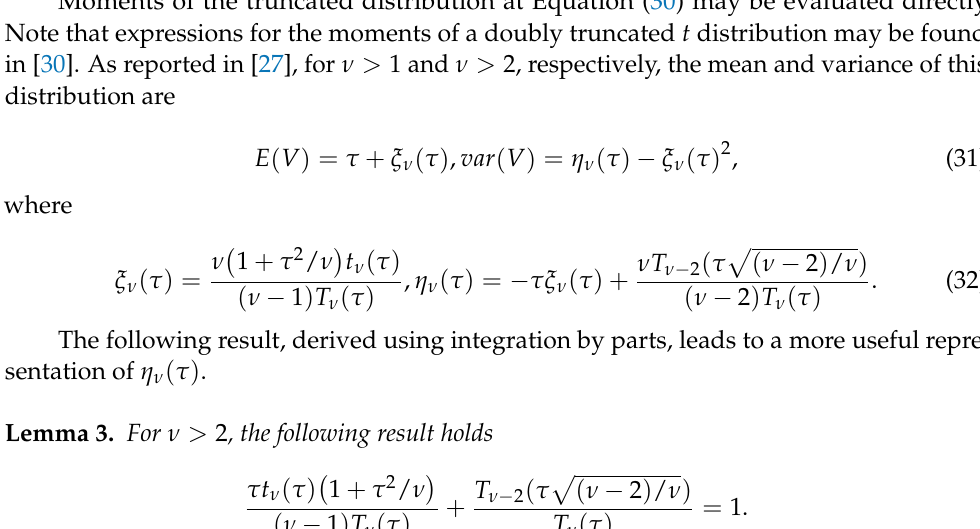
Figure 8. Truncated Student t density functions, τ = − 35, ν =